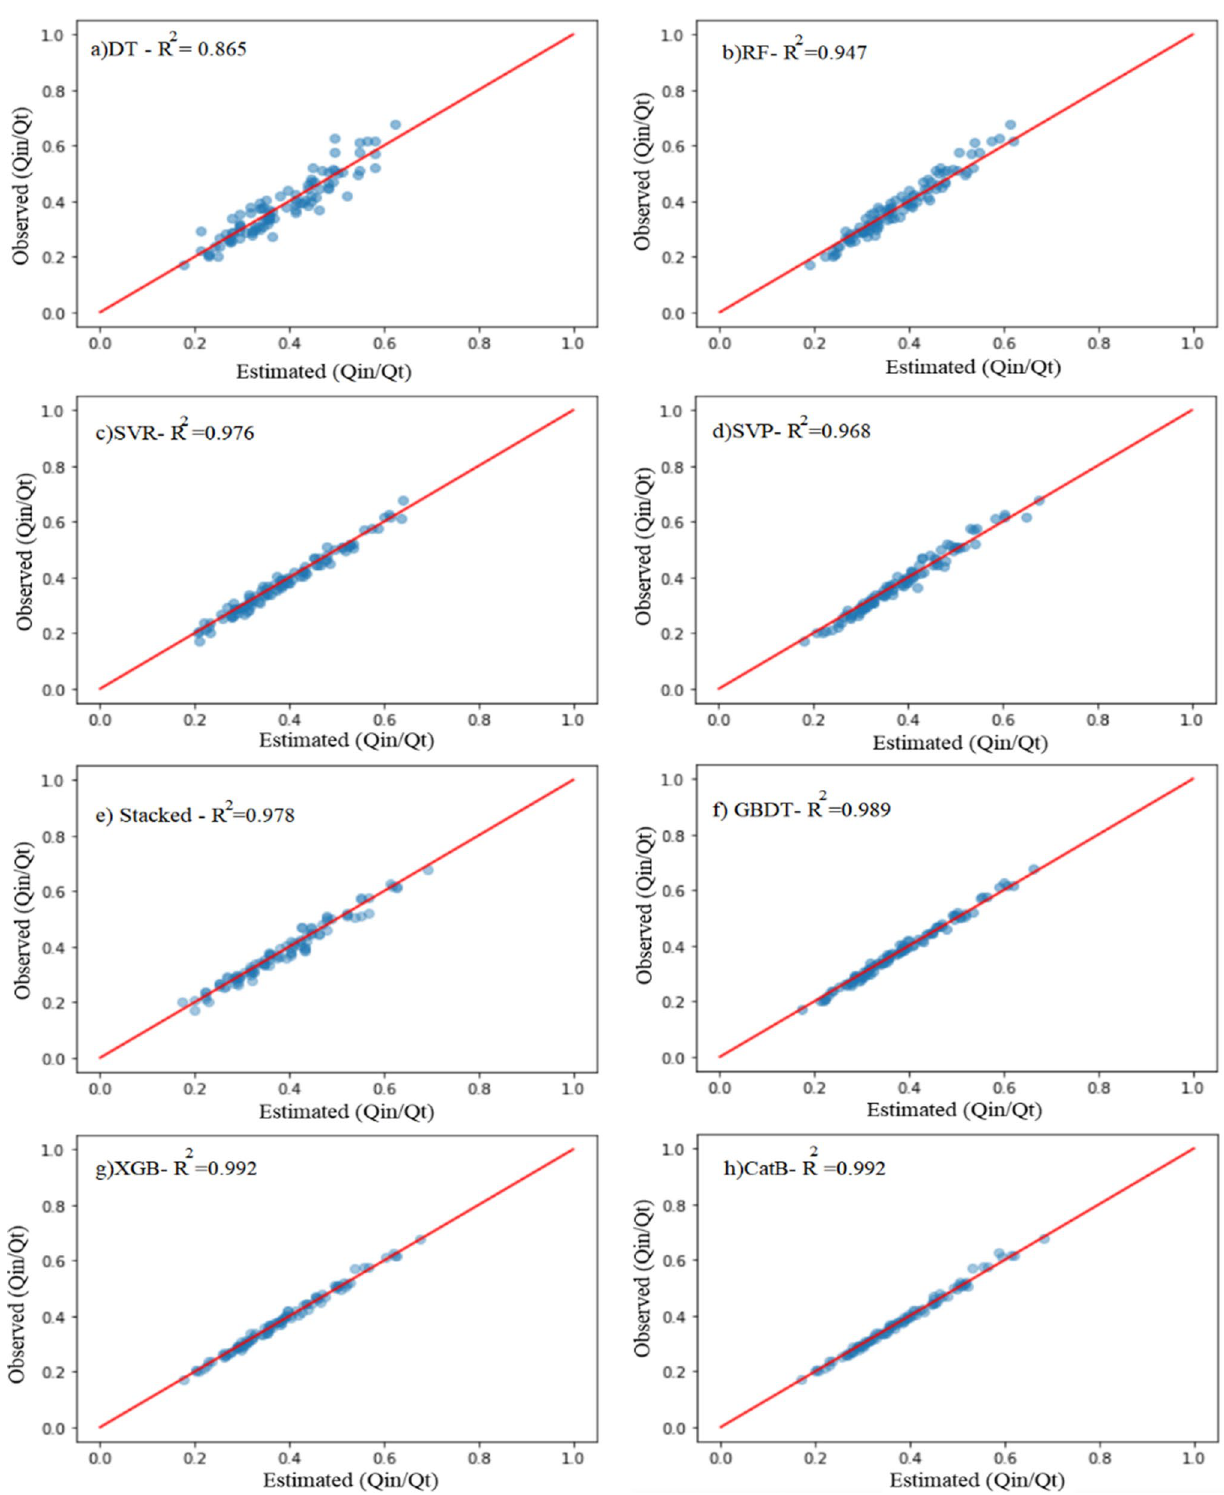
Fig. 12 Scatter plot of observed vs estimated values of Q